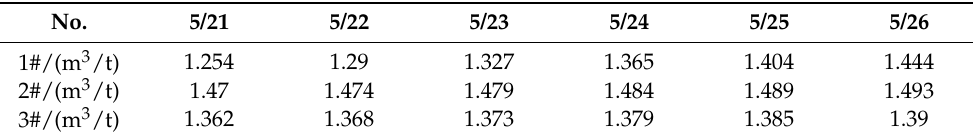
Table 2. Coal mining face gas prediction data.